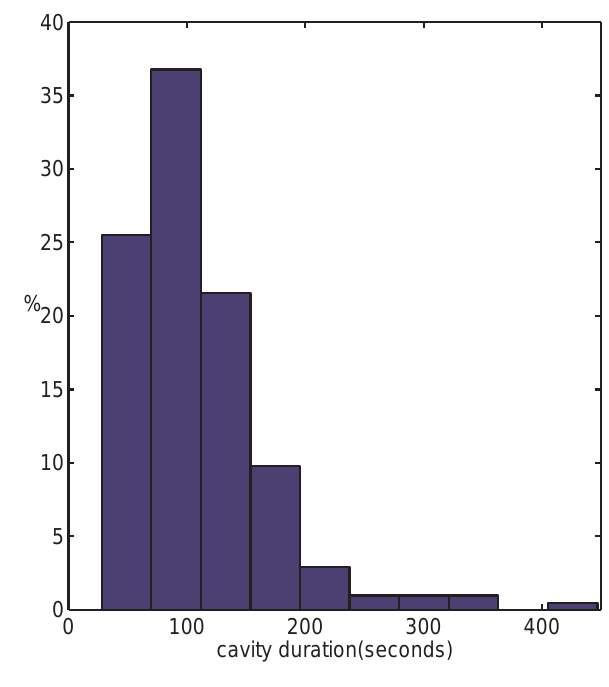
Fig. 10. Histogram of the durations of foreshock cavities. Timings were taken from the edges of the magnetic field depressions.